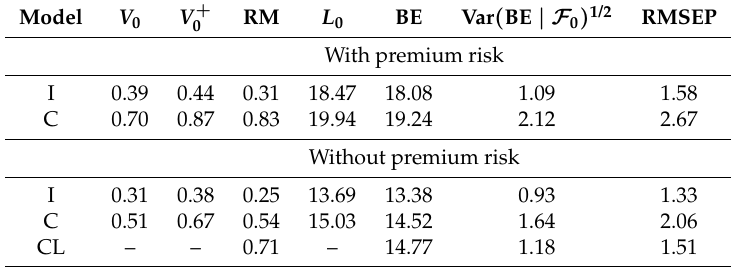
Table 1. Summary table. Values are expressed in millions. RM, risk-margin; BE, best